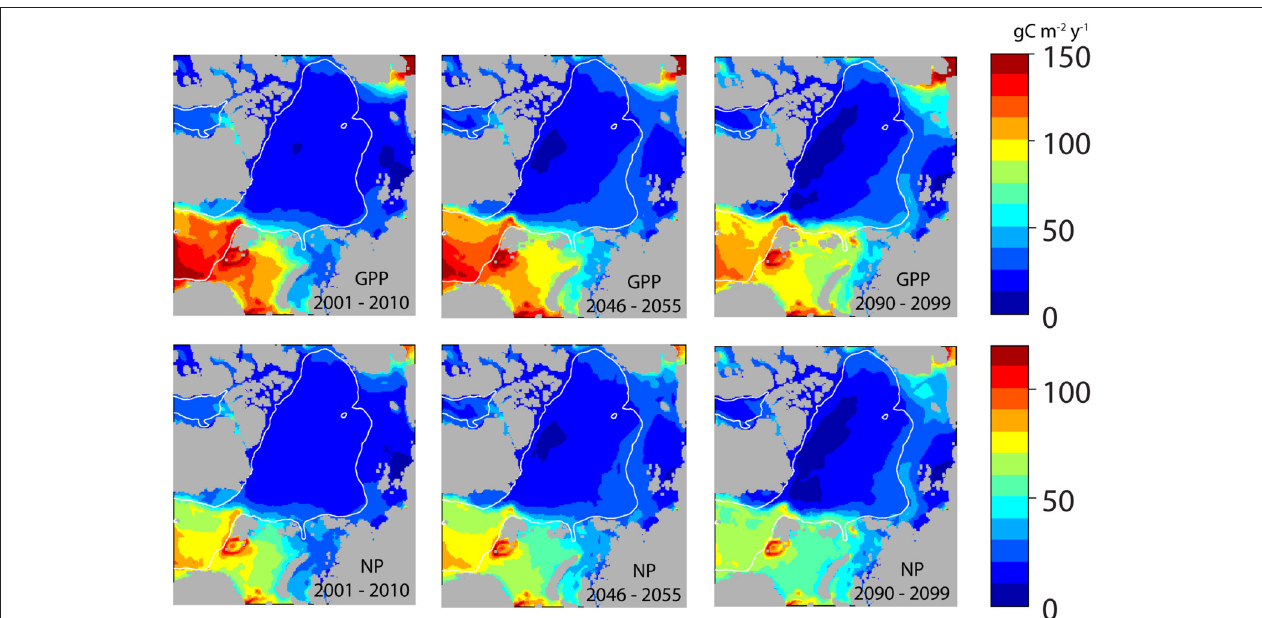
FIGURE 8 | Simulated 10 year mean production gross primary production (GPP, upper panels) and new production (NP, lower panels) in the entire Arctic Ocean (A1B) at present (2001–2010), in 2046–2055 and 2090–2099 (g C m − 2 y − 1